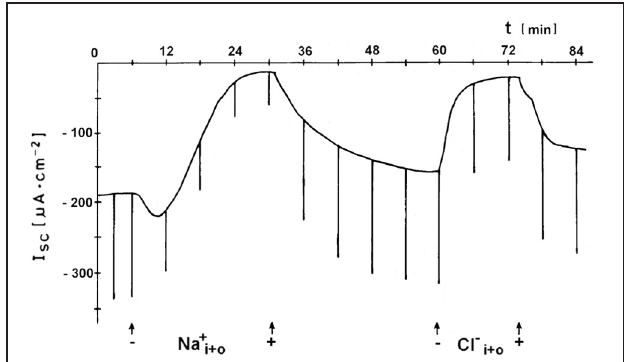
FIGURE 3 | Coupled absorption of NaCl in hyperosmoregulating species characterized by “leaky” gill epithelia. Representative time-course of the short-circuit current (I sc ), showing the effects of either Na + substitution (choline) or Cl − substitution (gluconates) on both sides of a split gill lamella of the shore crab Carcinus maenas . Current deflections are due to 5mV voltage pulses and are directly proportional to the transepithelial conductance (from Onken and Siebers,